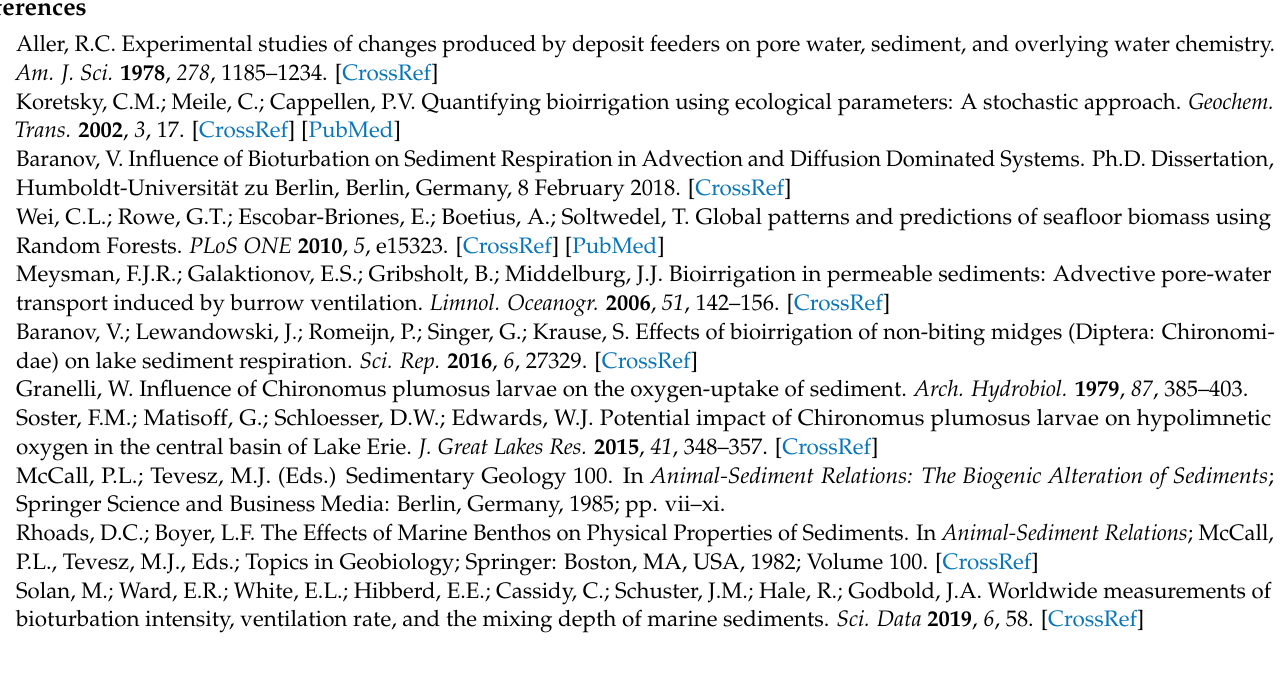
S2: List of abiotic predictors and collinearity check results; Figure S1: Figure showing time-series of BIPc values at 8 monitoring stations; Figure S2: Correlations of BIPc values with measured bioirrigation rates. (a) Correlations of predicted BIPc values with bioirrigation constants resulting from bromide tracer experiments estimated for various depth intervals, as reported in Powilleit and Forster (2018). (b) Pearson correlation coefficients (above the diagonal) with significance levels ( p -value below the diagonal) calculated between bioirrigation intensity measured with bromide tracer and macrofauna-based parameters; File S1: GIS layers of modelled BIPc